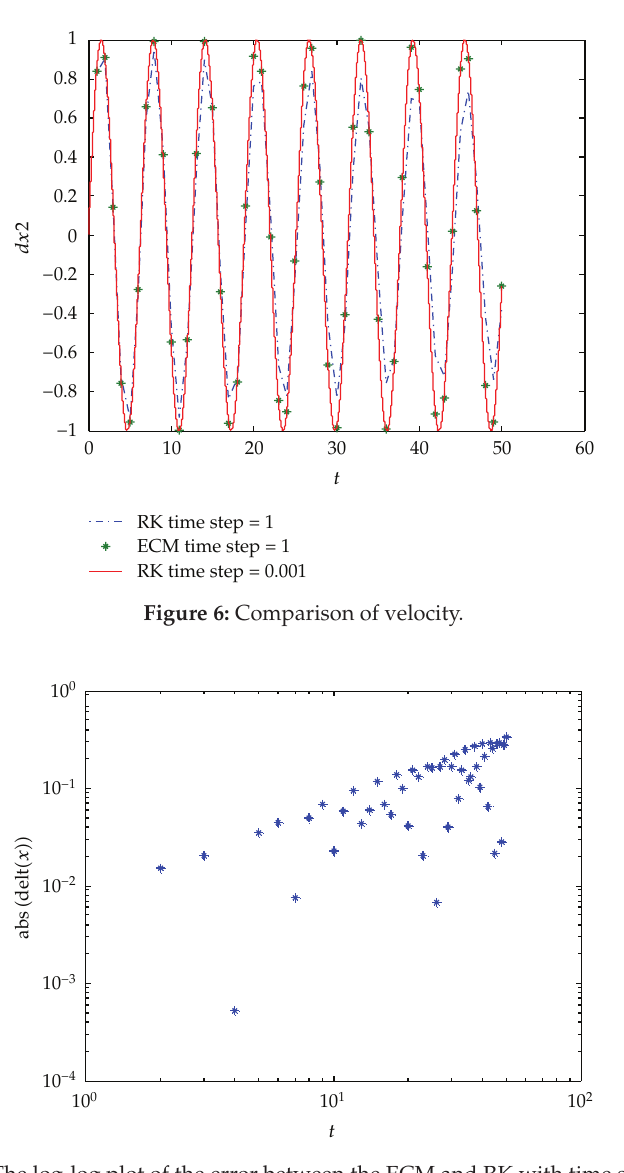
Figure 7: The log-log plot of the error between the ECM and RK with time step